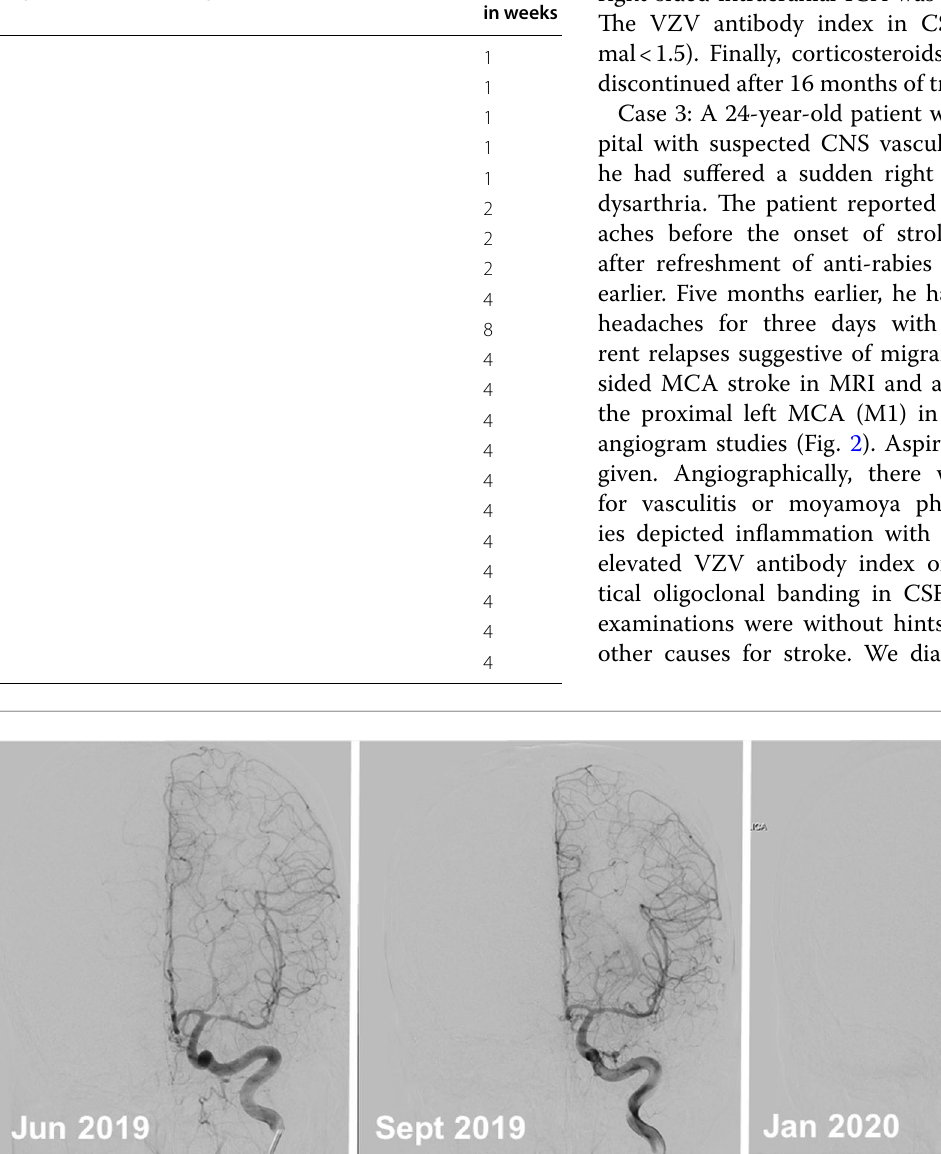
Table 2 Potential dosage regimen of oral prednisolone after induction therapy Dosage prednisolone in mg